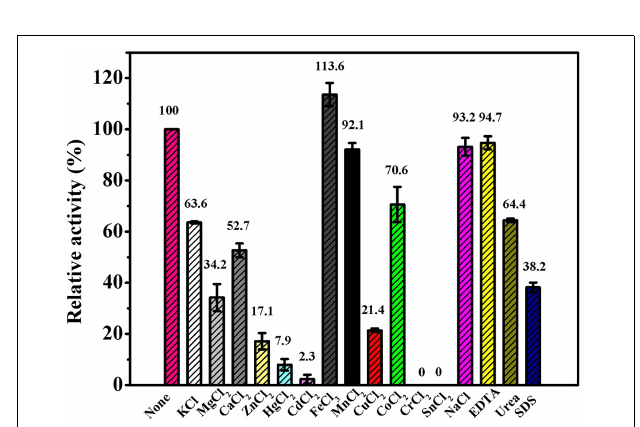
FIGURE 7 | The effects of different reagents on the Ps-Grx3 activity. The above experiments were carried out three times.